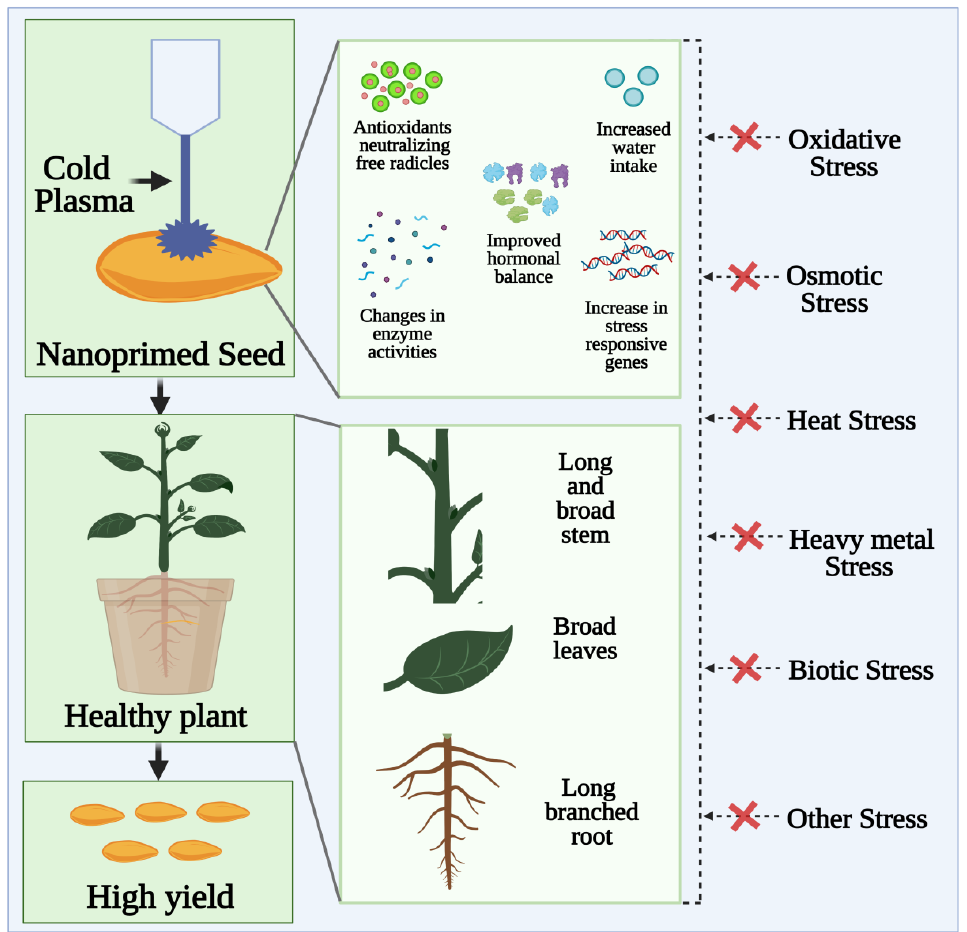
Figure 6. As an alternative to ecotoxic chemical treatments, non-thermal and cold plasma-based seed nanopriming has advantages in managing environmental stressors towards improving seed vigor and enhancing seed germination. The enhanced antioxidant system and activated defense response towards improved physiological processes; seed scarification and pathogen inactivation via plasma affects seed surface environment ameliorating improved features at molecular level and leave/root/shoot proportions.